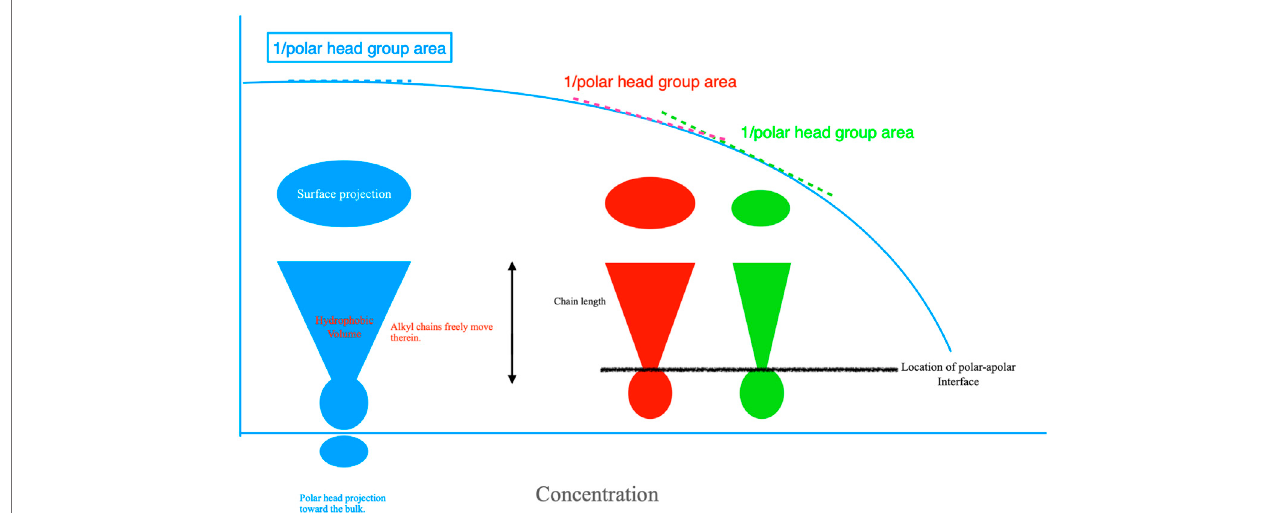
FIGURE3| Left;cut-viewprojectionofasurfactantattheair-waterinterface.Chainsarehiddenintocones.Thepolarheadprojectiontowardthebulkdecreasesas a direct consequence of composition. The same holds for the surface projection, whose value is inversely proportional to Γ 2 . The higher is it, the lower the surface area. Surfactants pack more or less densely in mono-layers of width equal to the alkyl chain length and pass from a liquid expanded to a liquid compressed state until a compact layer is attained. That behavior corresponds to a liquid-solid phase transition. Red and green cones overlapping with the γ vs. concentration plot, in light blue, containanalkylchainofthesamelengthastheblueone,butinmorecompactform; thisimpliesthatthesurfaceprojectionislower.Alkylchains arelikewhips,with polar areas anchoring them at the polar-apolar interface. The degrees of motion of the alkyl chains do reduce in direct proportion to the cone(s) volume.